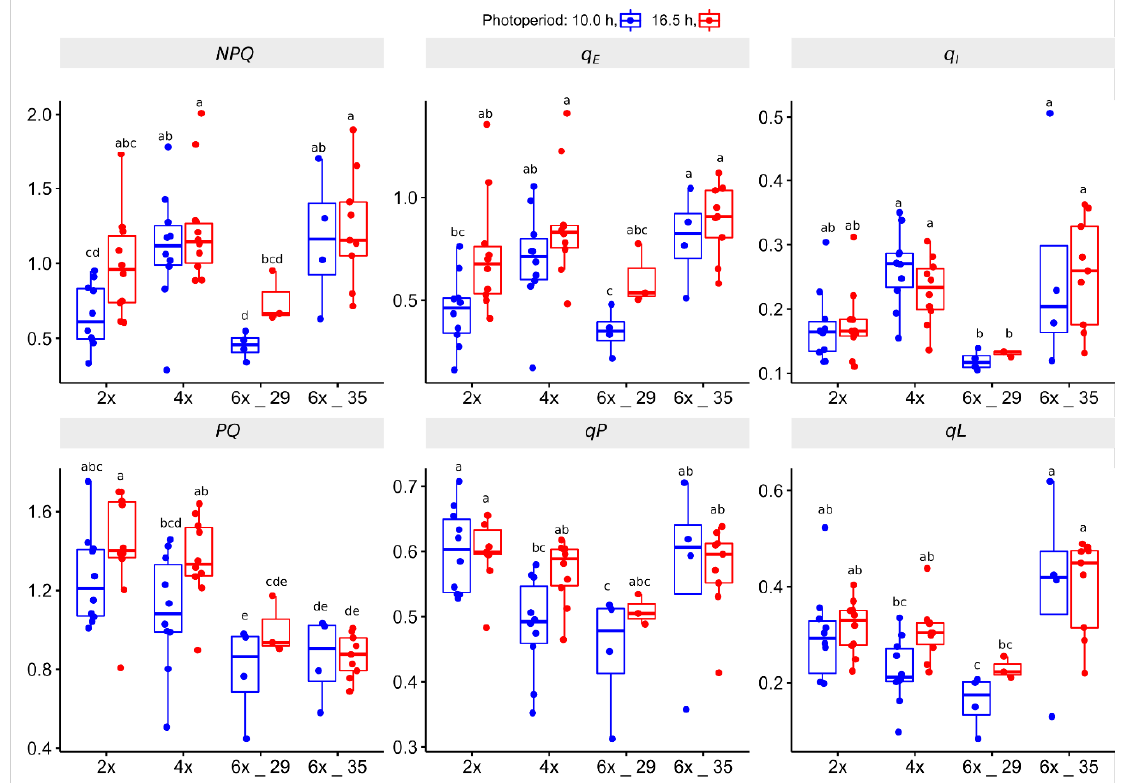
Figure 5. Coefficients calculated from Kautsky curve (KC) experiments of R. auricomus cytotypes exposed to two different photoperiods; non-photochemical quenching: NPQ, qE (heat dissipation NPQ), qI (photoinbitory NPQ); photochemical quenching: PQ , qP , qL (estimates of open non-reduced PSII centers). For summary statistics, see Table S6, letters represent 95% Duncan. Boxplots show the 25th, median, and 75th percentile range, and jitter plots represent the exact data distribu- tion.